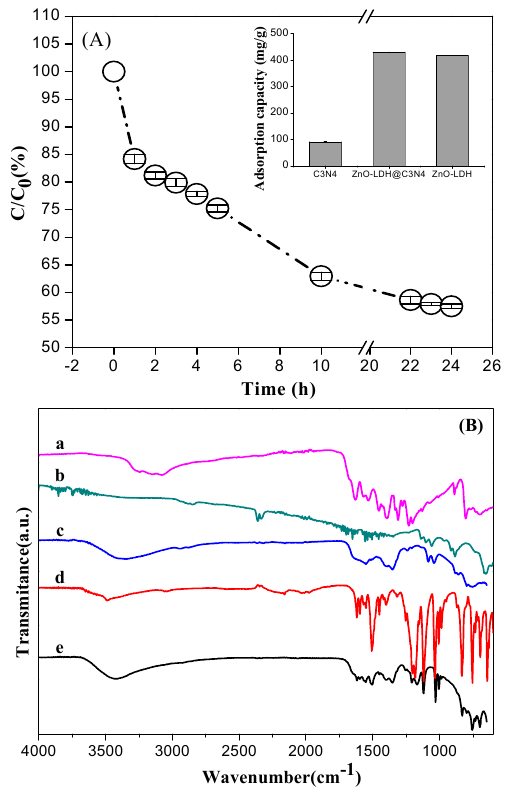
Figure 4. ( A ) The adsorption dynamic of ZnO-LDH@C 3 N 4 in OrgII adsorption. The insert is adsorption capacity comparison among g-C 3 N 4 , ZnO-LDH@C 3 N 4 and ZnO-LDH; ( B ) FT-IR spectra of ( a ) g-C 3 N 4 , ( b ) ZnO-LDH, ( c ) ZnO-LDH@C 3 N 4 , ( d ) OrgII, ( e ) ZnO-LDH@C 3 N 4 after saturated adsorption with OrgII.